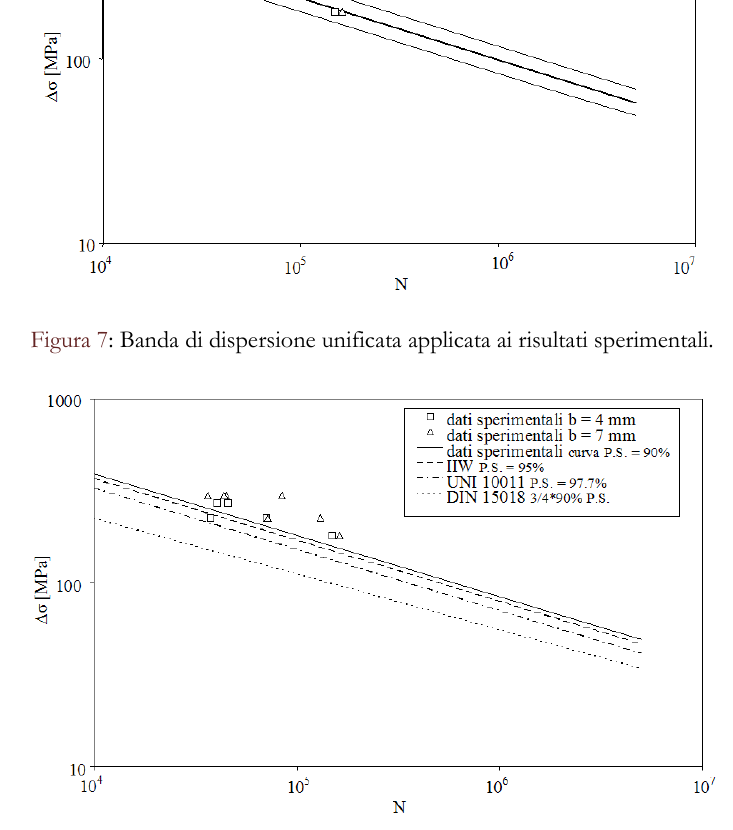
Figura 8: Confronto tra normative e risultati